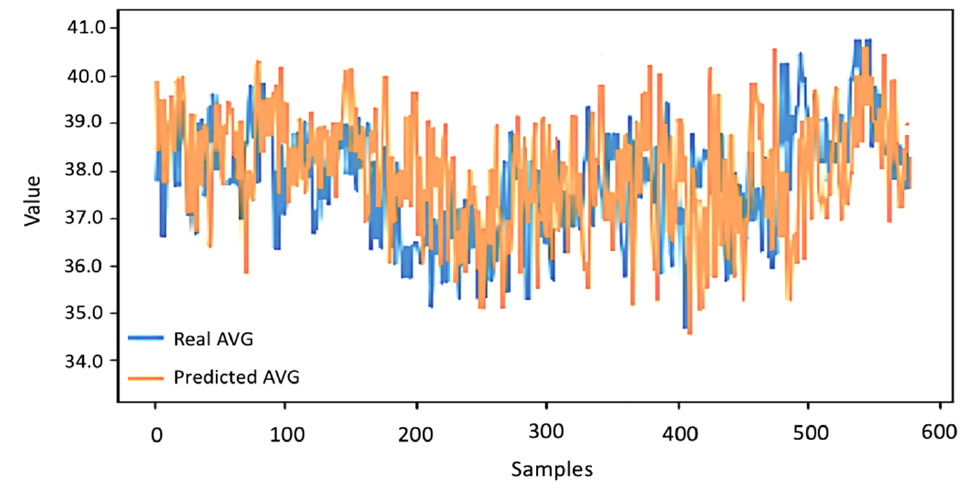
Figure 6. Real and 15-days forecast values (after smoothing) using non-overlapping windows for current.